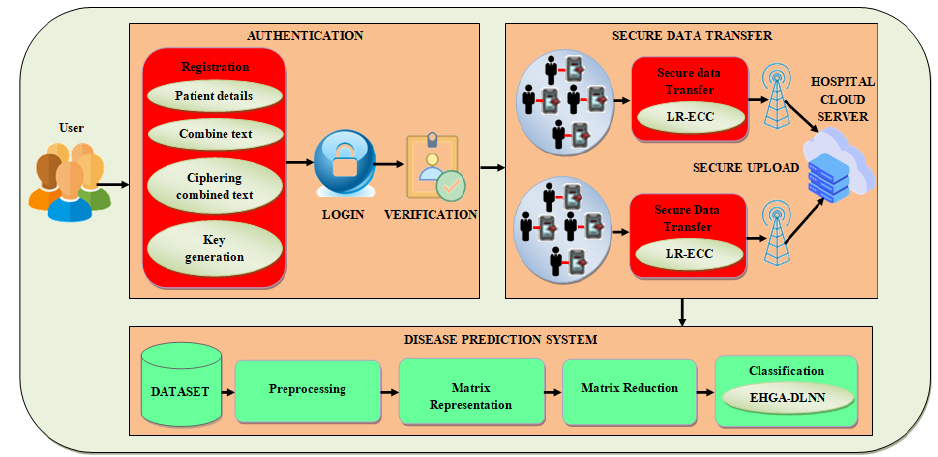
Figure 1. Architecture diagram of the proposed methodology.